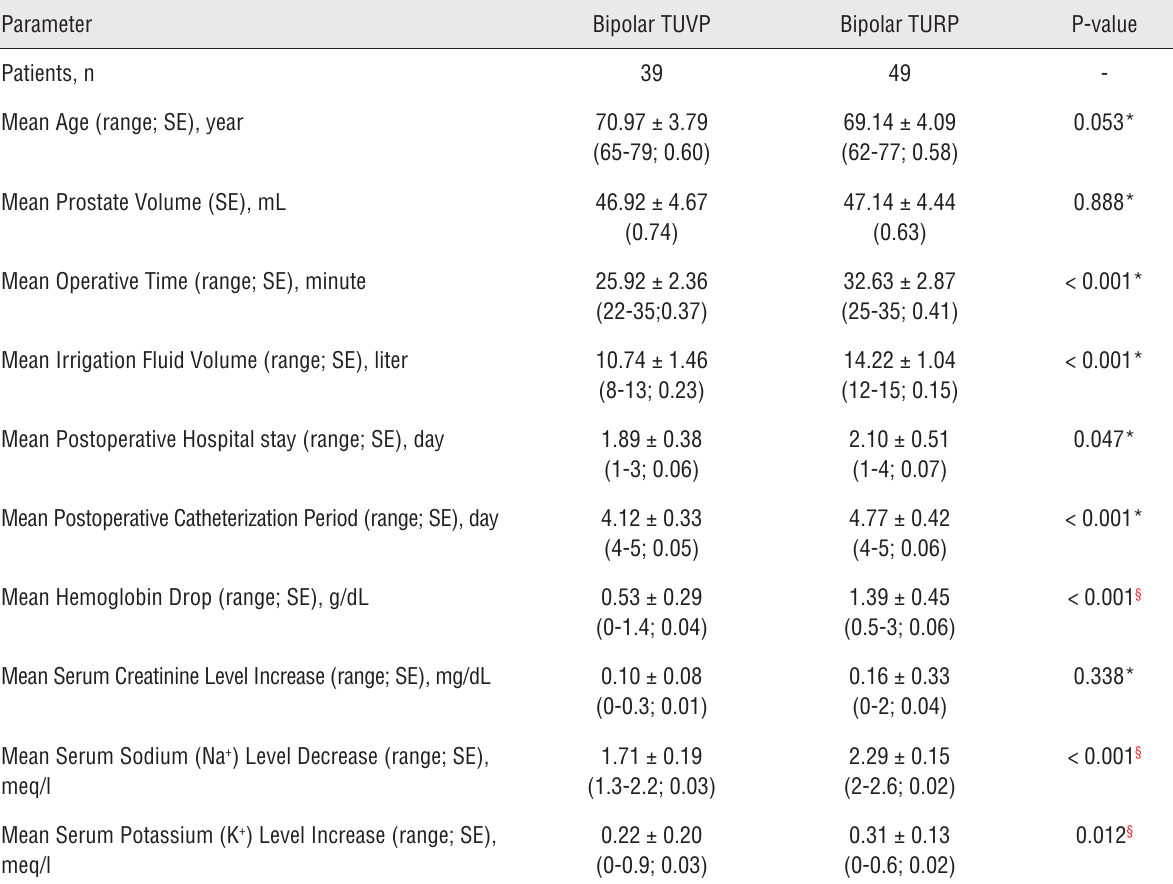
Table 1 - Patient- and operation-related parameters in Bipolar TUVP and Bipolar TURP groups. Parameter Bipolar